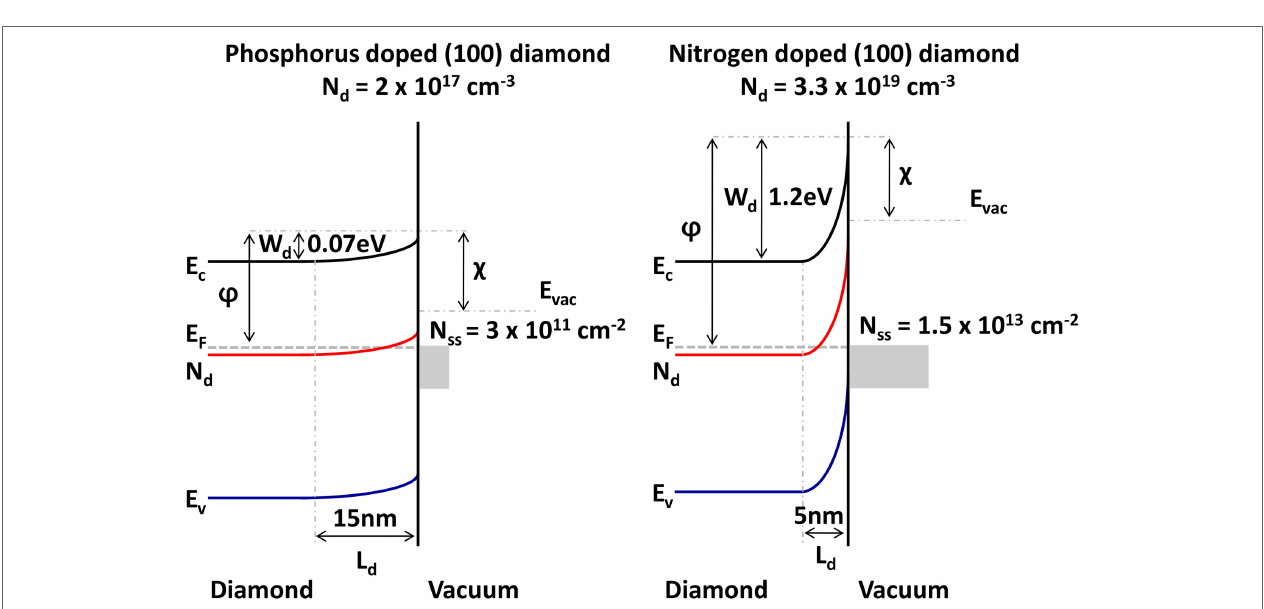
FIGURE 9 | Band bending schematic for single-crystal (100) diamond with different doping concentration of 2 (cid:2) 10 17 cm (cid:0) 3 for phosphorus-doped diamond and 3.3 (cid:2) 10 19 cm (cid:0) 3 for nitrogen-doped